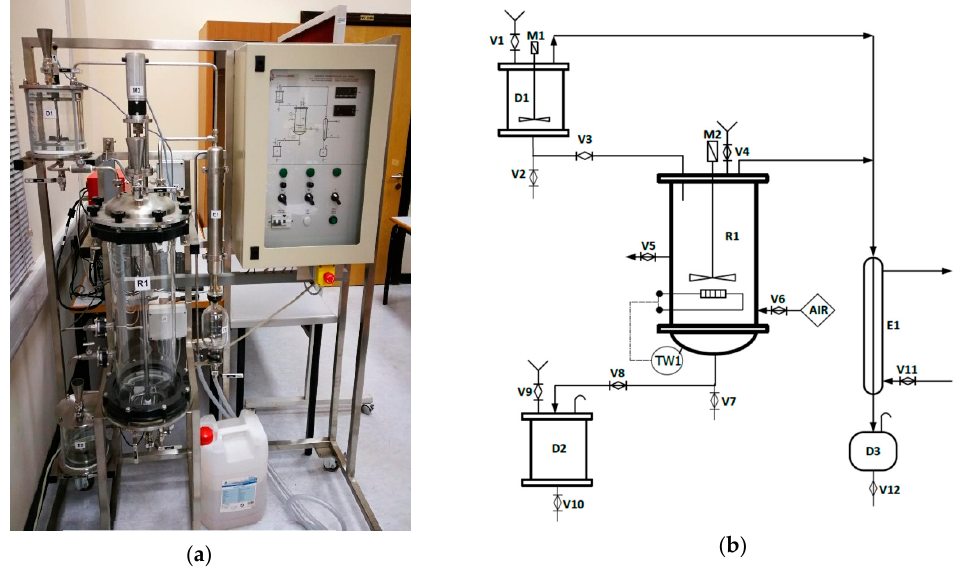
Figure 5. Biodiesel production plant: ( a ) Photograph and ( b ) schematic diagram with parts labelled for the tank (D), condenser (E), reactor (R), and valves (V) (see text for specific descriptions).